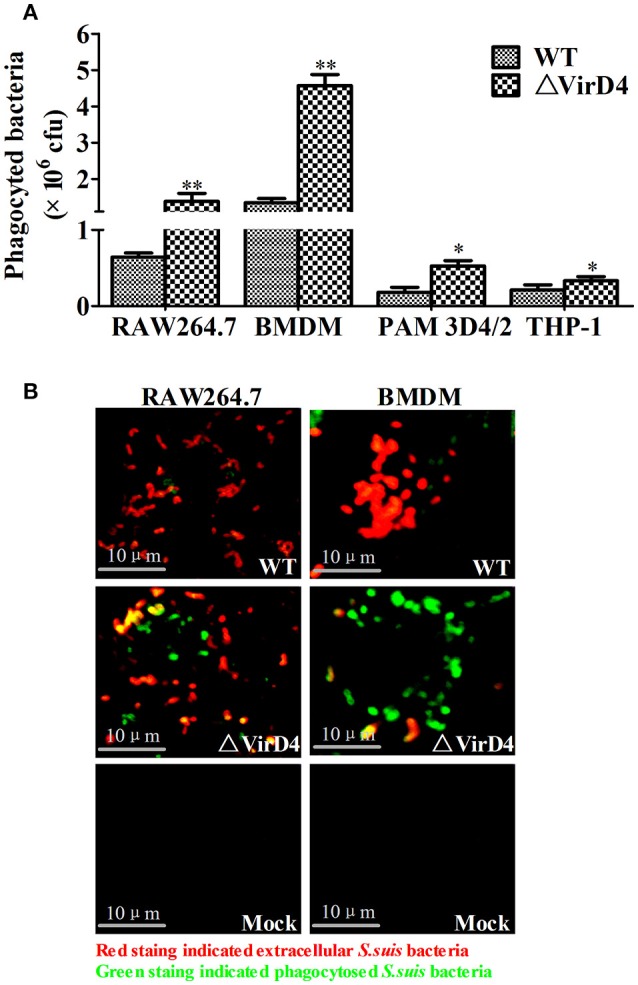
Deletion of virD4 rendered the bacteria more easily phagocytosed by murine or porcine macrophage cell lines. (A) Primary bone marrow macrophages (BMDM) from C57BL/6 mice and murine macrophage cell line RAW264.7, porcine alveolar macrophage (PAM) 3D4/2 and human monocytic cell line THP-1 were infected with wild-type (WT) S. suis type 2 or ΔVirD4 mutant strains (MOI at 100) for 2 h, respectively. After 1 h treatment with gentamicin, phagocytosed bacteria were counted on BHI agar plates. All experiments were repeated at least three times (each in triplicate samples) and showed similar trends. Data were shown as mean ± SD of three replicate wells of a typical experiment. “*” or “**” indicated significant at P < 0.05 or P < 0.01, respectively. (B) Immunofluorescence for observation of phagocytosed bacteria. Bacteria were stained by rabbit anti-SS2 whole cell serum. Extracellular and intracellular bacteria were distinguished by red (TRITC) and green (FITC)-colored secondary antibody staining. Bar scale indicated were 10 μm.